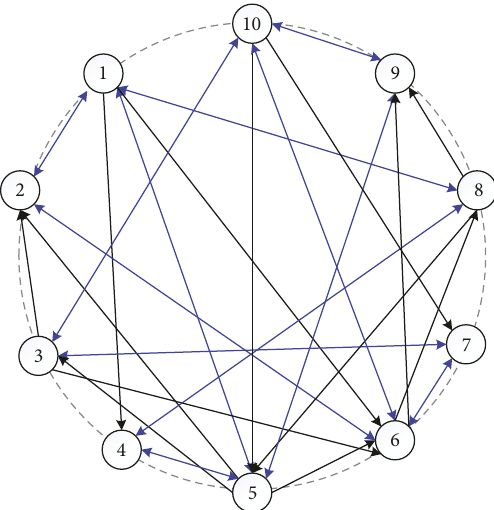
Figure 1: The strongly connected time-varying graph.